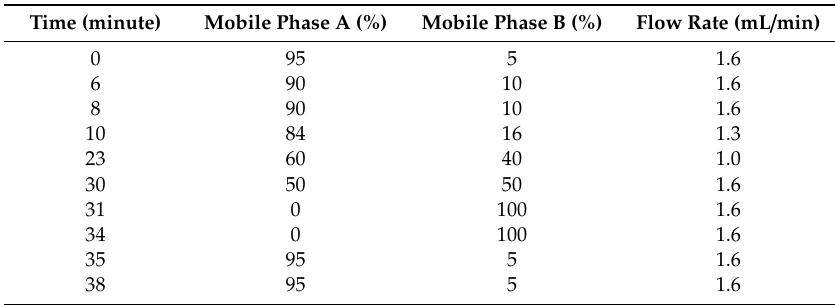
Table 1. Mobile phase-gradient elution procedure.